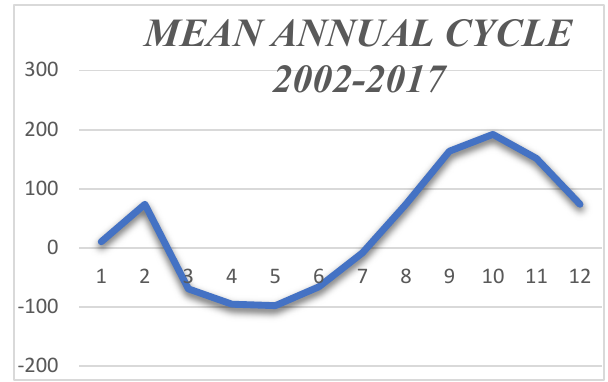
Figure 6. Spatial Trend of TWS